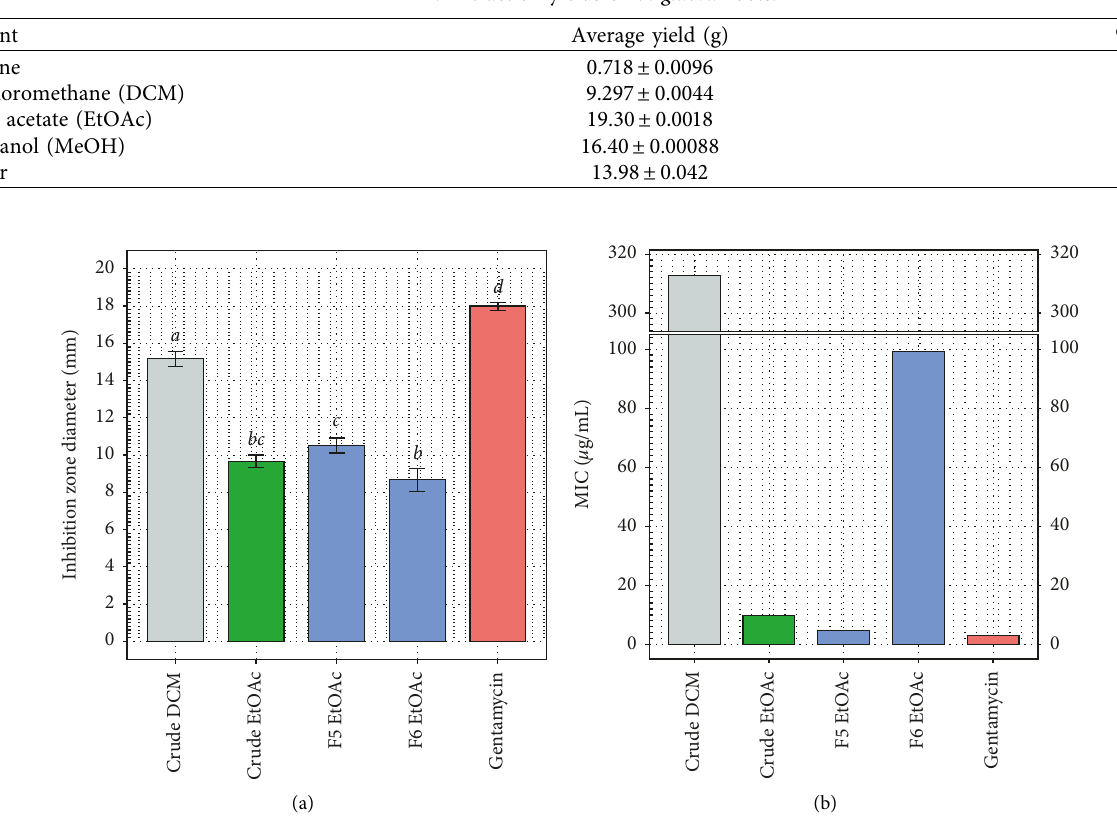
Figure 2: (a) Mean inhibition zone diameter of the bioactive crude extracts and EtOAc fractions against M. tuberculosis at a single concentration of 1.25mg/mL. In each plot, means of test samples with the same letter have insignificant differences ( p � 0 . 05). (b) Minimum inhibitory concentration (MIC) of bioactive crude extracts and